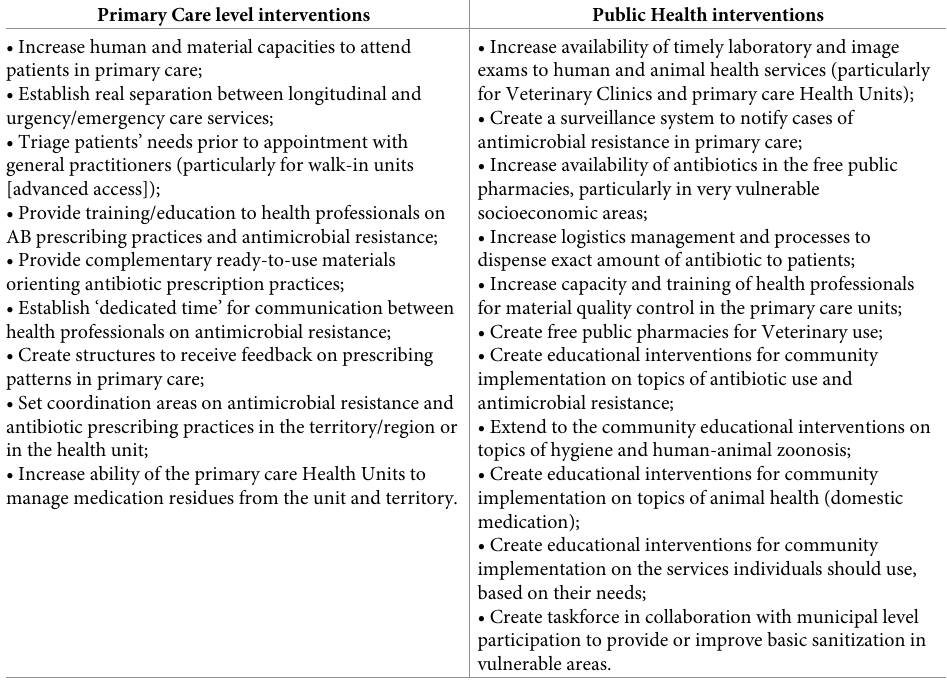
Table 2. Potential interventions in critical areas raised by human and animal health